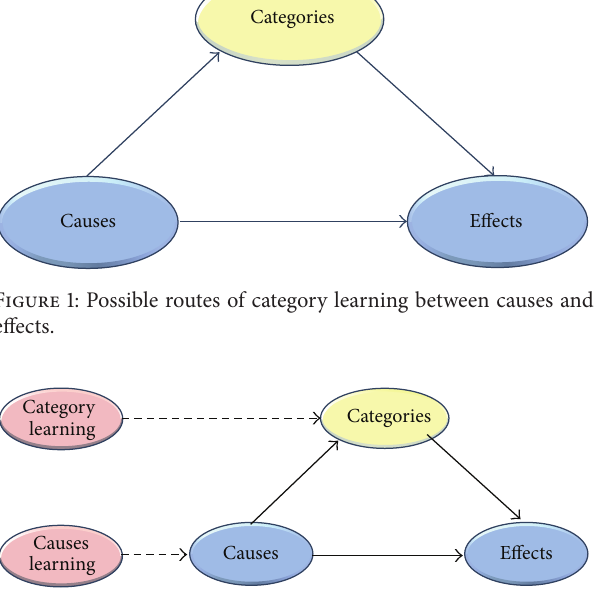
Table 1: Statistics for backward causality